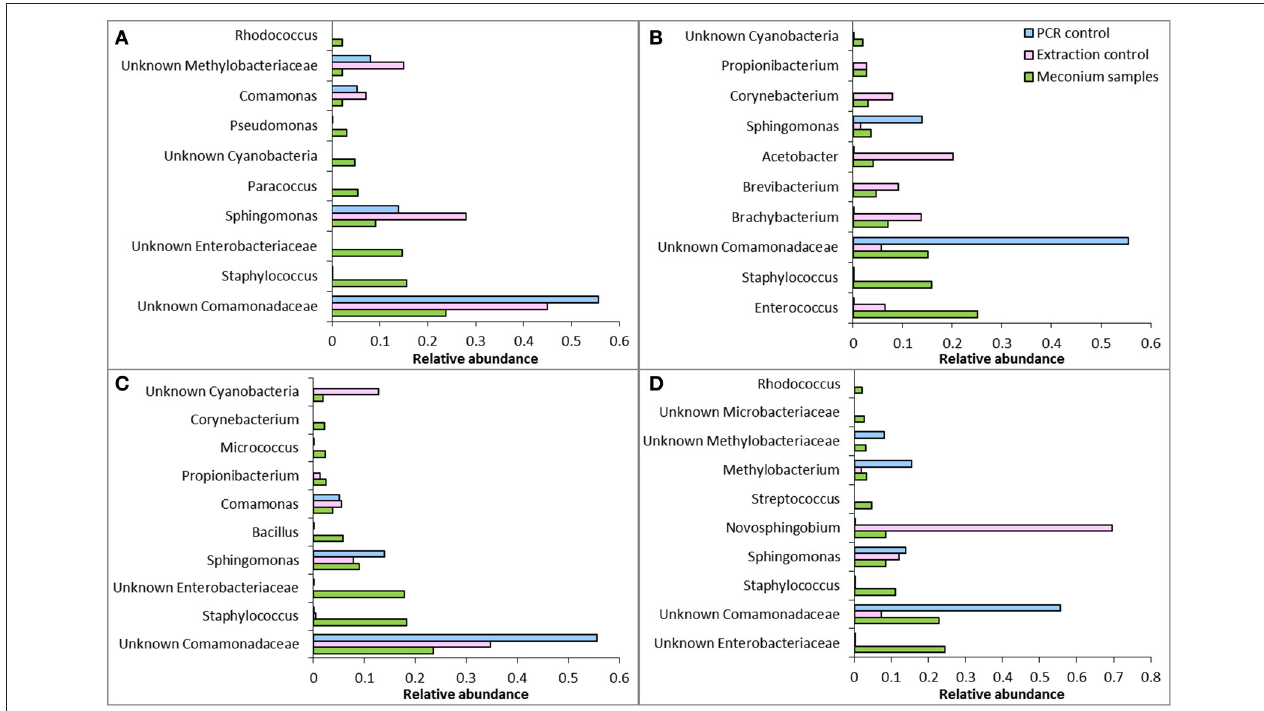
FIGURE 6 | Comparison of relative abundance of the 10 most abundant OTUs in meconium samples with extraction controls and PCR controls from (A) kit QS, (B) kit QM, (C) kit PS, and (D) kit PM. Note that abundances are relative and not absolute, so a direct comparison of abundance cannot be made between meconium samples, PCR controls and extraction